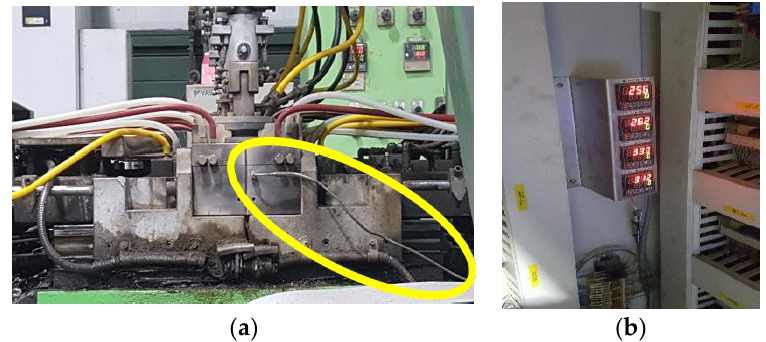
Figure 3. Installation of sensor and controller in the factory: ( a ) thermocouple sensor attached to the mold; ( b ) controller.